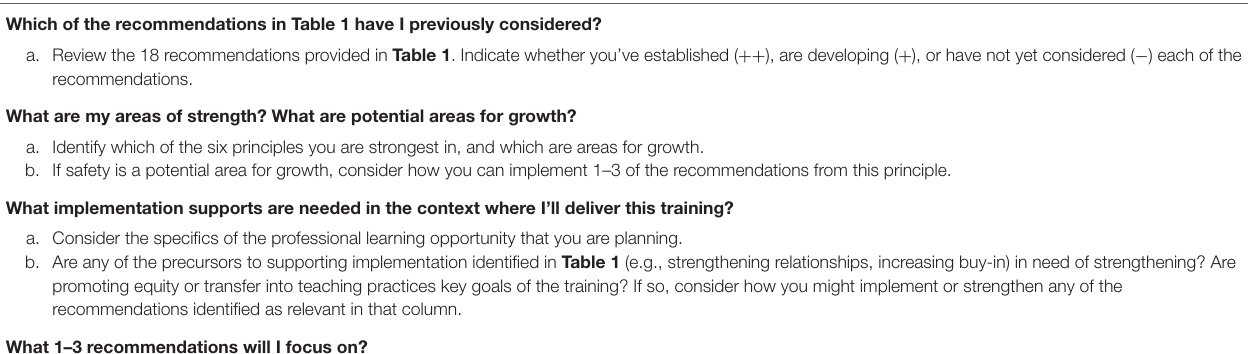
TABLE 2 | Questions to guide facilitator action planning to deliver professional learning that is trauma